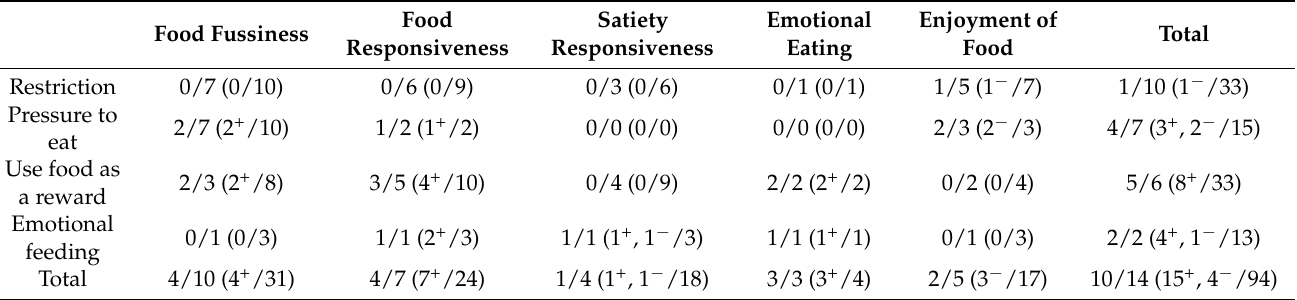
Table 3. Summary of longitudinal effects from feeding practices to child eating behaviors (F →